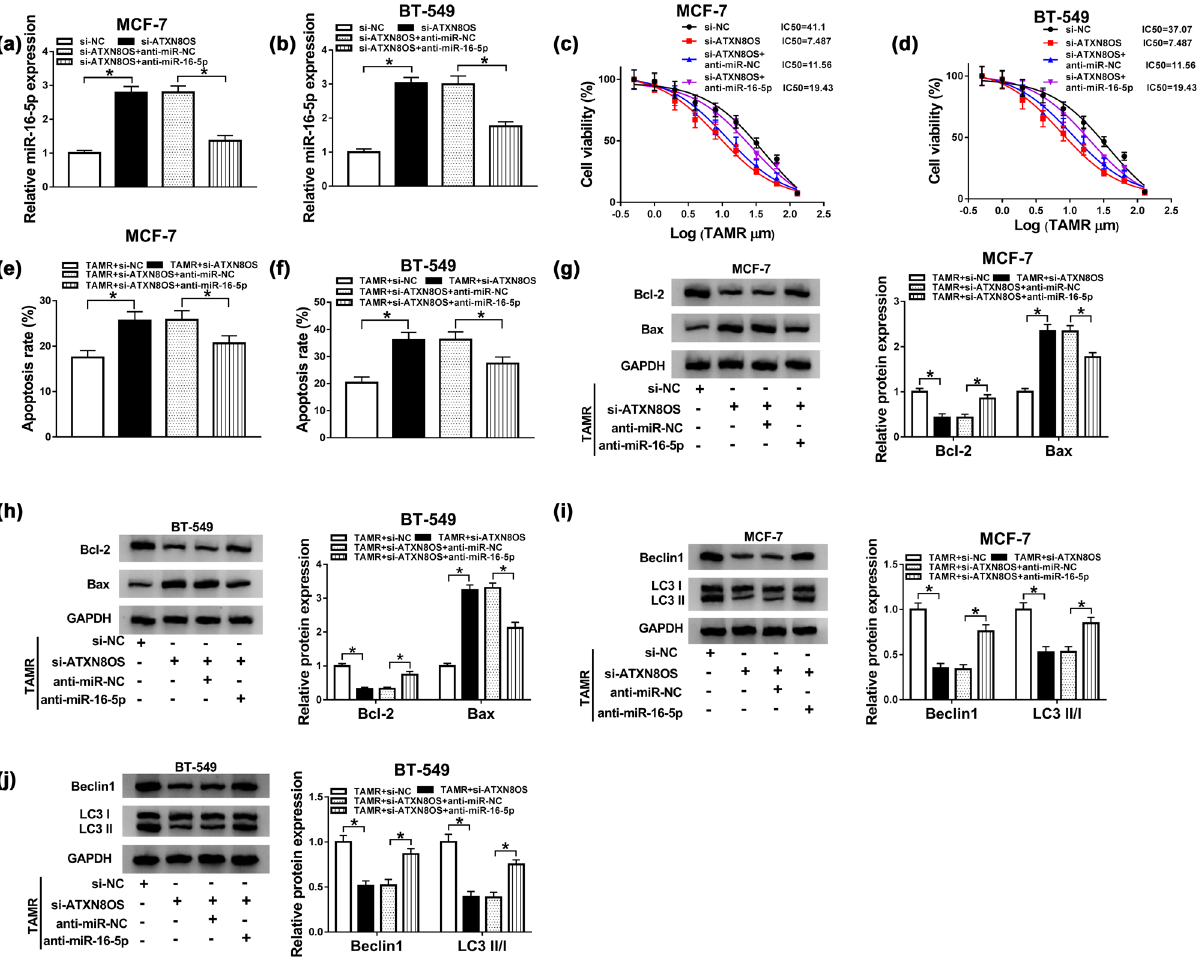
Figure 4: The knockdown of ATXN8OS enhanced TAMR sensitivity by upregulating miR - 16 - 5p. MCF - 7 and BT - 549 cells were transfected with si - NC, si - ATXN8OS, si - ATXN8OS + anti - miR - NC, and si - ATXN8OS + anti - miR - 16 - 5p before TAMR treatment with the indicated concentrations, followed by the measurement of miR - 16 - 5p expression by qRT - PCR ( a and b ) , the IC 50 value for TAMR by MTT assay ( c and d ) , cell apoptosis by fl ow cytometry ( e and f ) , Bcl - 2 and Bax levels by western blot ( g and h ) , and the levels of Beclin 1, LC3 I and LC3 II by western blot ( i and j ) . * P <